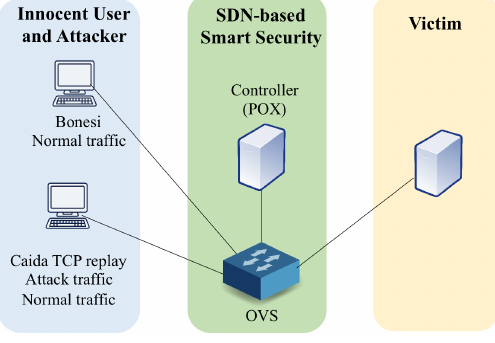
Figure 8. Testbed setup. Table 6. Testbed